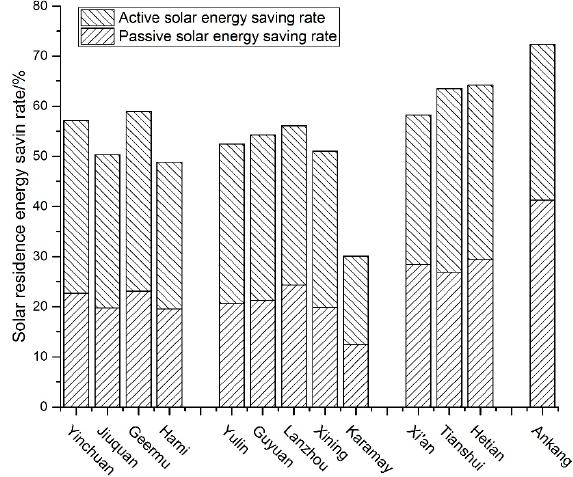
Figure 8. Comparison of energy saving rate in selected 13 typical cities with the proposed heating system.